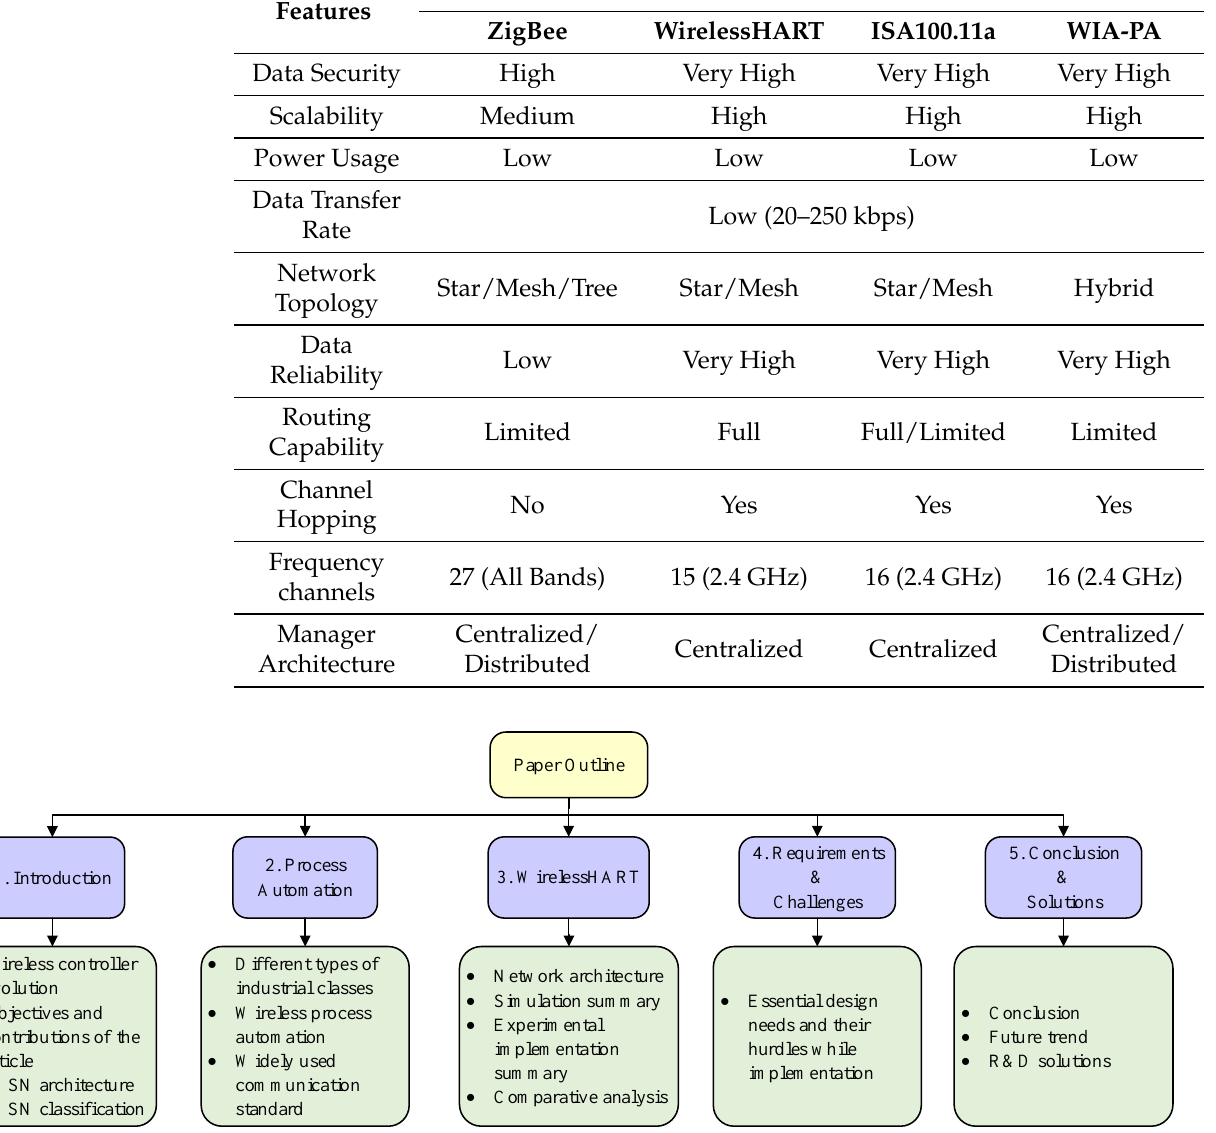
Figure 4. Content organization of the